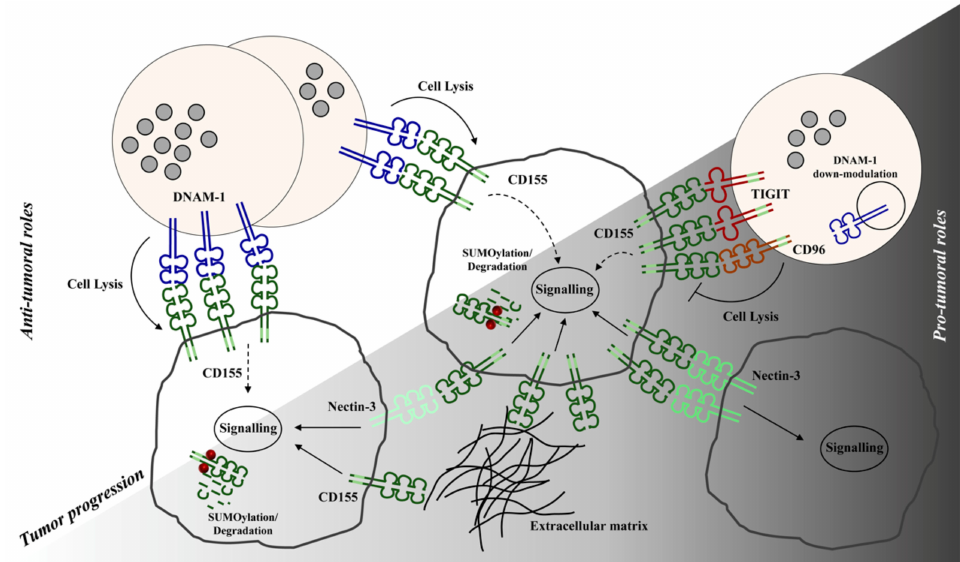
Figure 1. Model depicting CD155 multiple roles in tumor progression. Anti-tumoral and pro-tumoral CD155 roles are indicated with white and gray background, respectively. Temporal evolution of tumor is highlighted in shades of gray. CD155 represents an advantage for tumor cells (thick gray line) because its engagement initiates intracellular signals that favor proliferation, invasiveness and